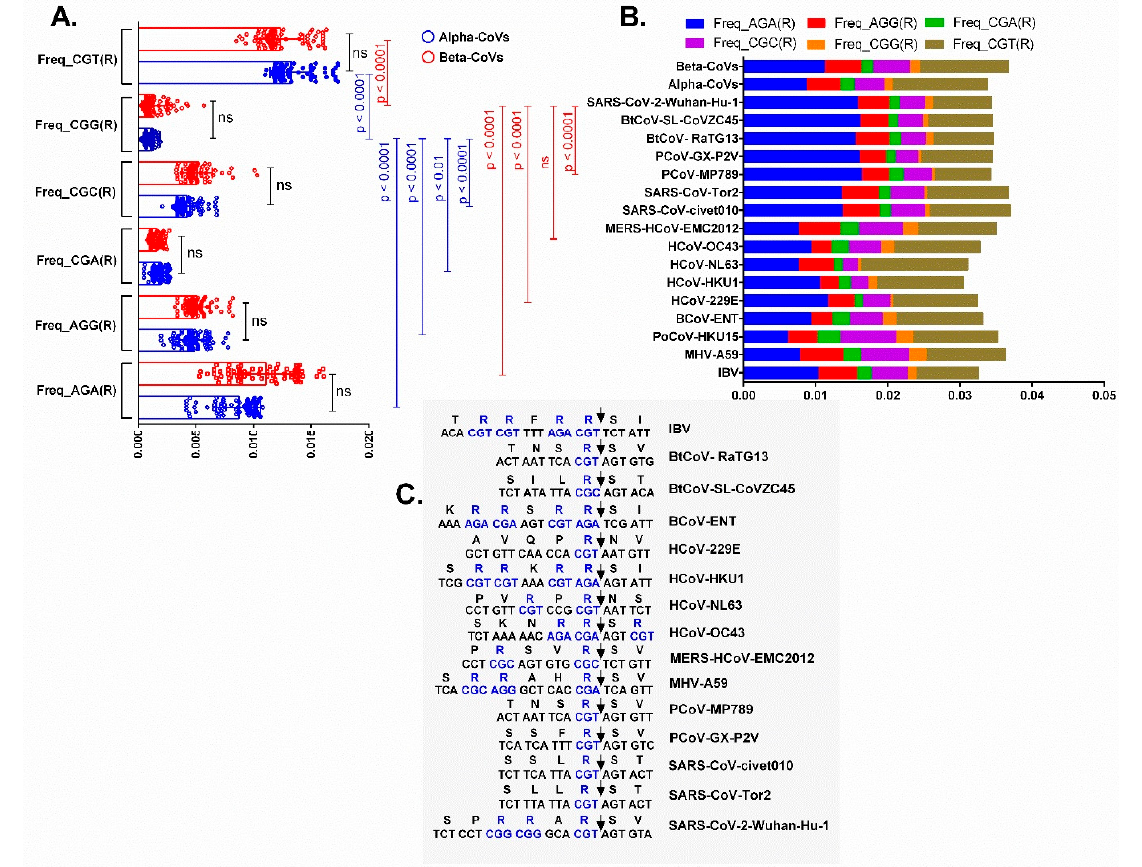
Figure 8. Frequency of arginine encoding synonymous codons in the complete genomic coding sequences of ( A ) chiroptera-hosted alpha- and beta-CoVs, ( B ) animals and humans-hosted CoVs. ( C ) shows the distribution patterns of arginine-encoding codons in the furin-like cleavage sites of CoVs infecting different hosts. A p -value less than 0.01 is considered statistically significant, and ns represents non-significant difference between two